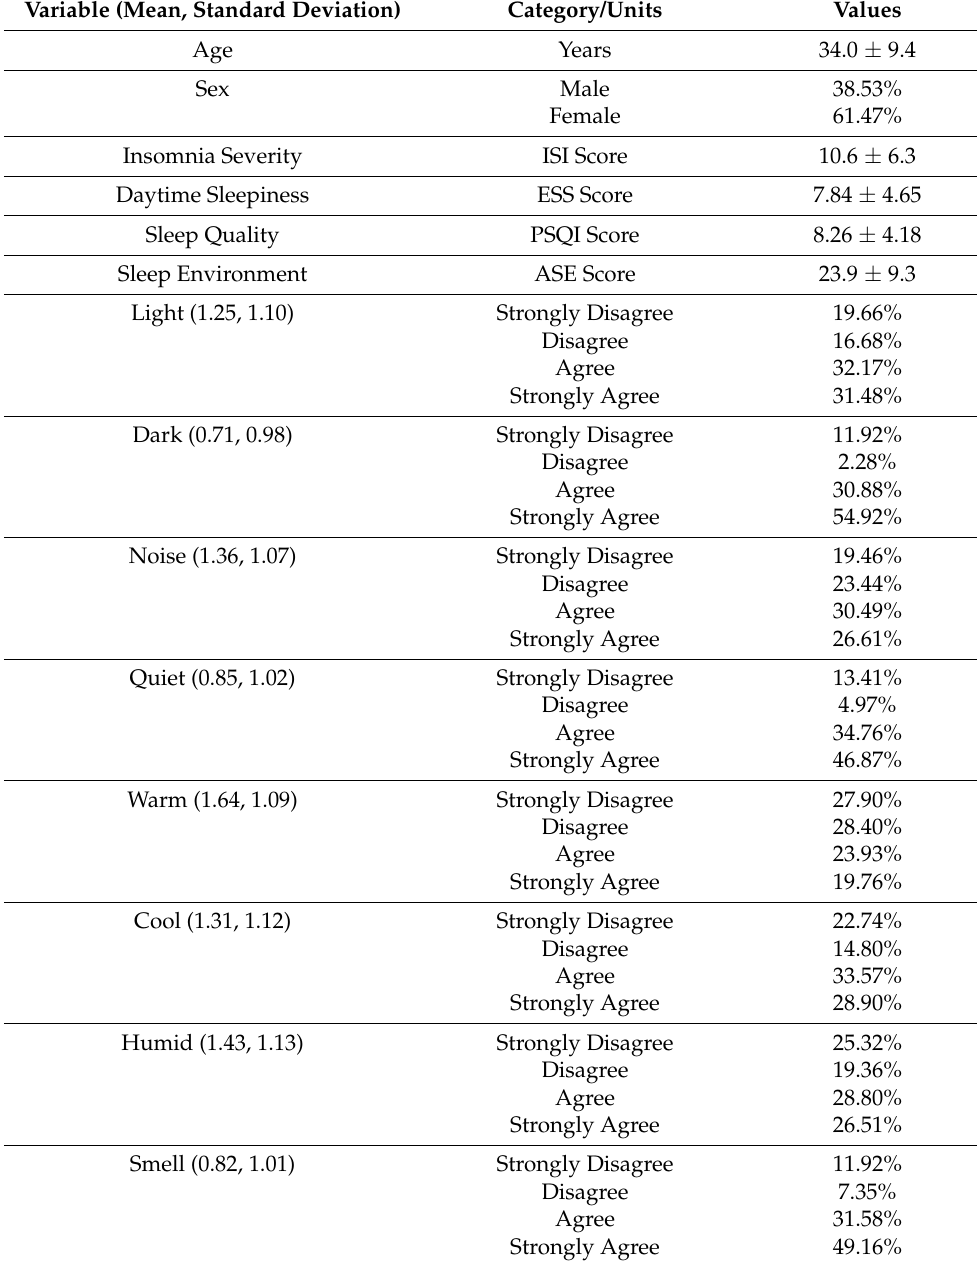
Table 1. Characteristics of the